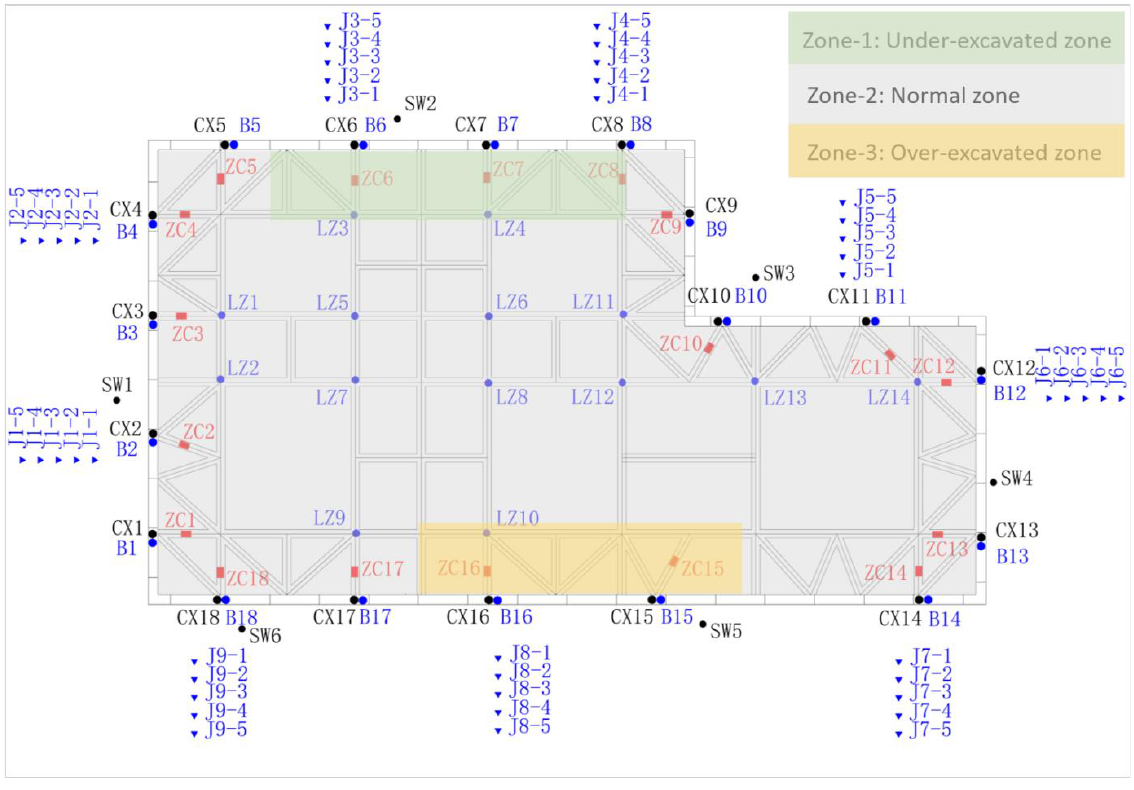
Figure 20. Developments of axial strut force at ZC15 and ZC16.